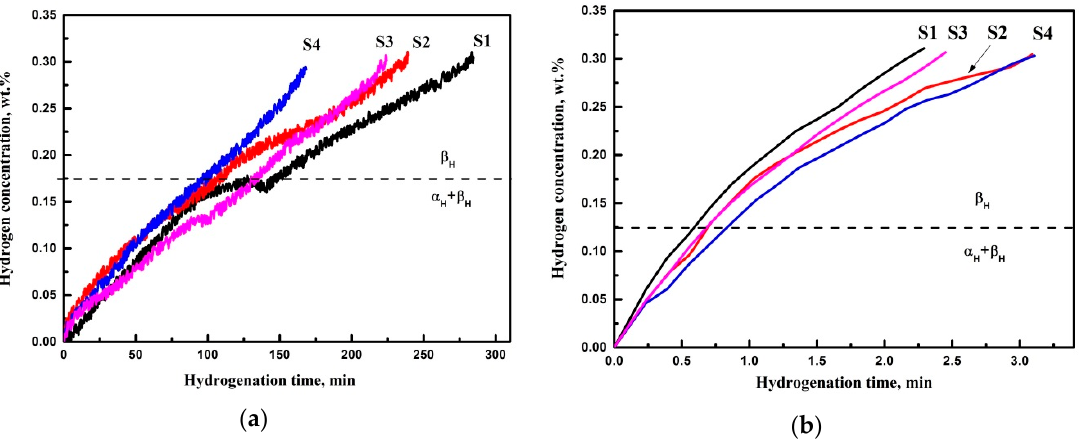
Figure 5. The kinetic curves of hydrogen absorption: ( a ) T = 500 ° С ; ( b ) T = 650 ° С .